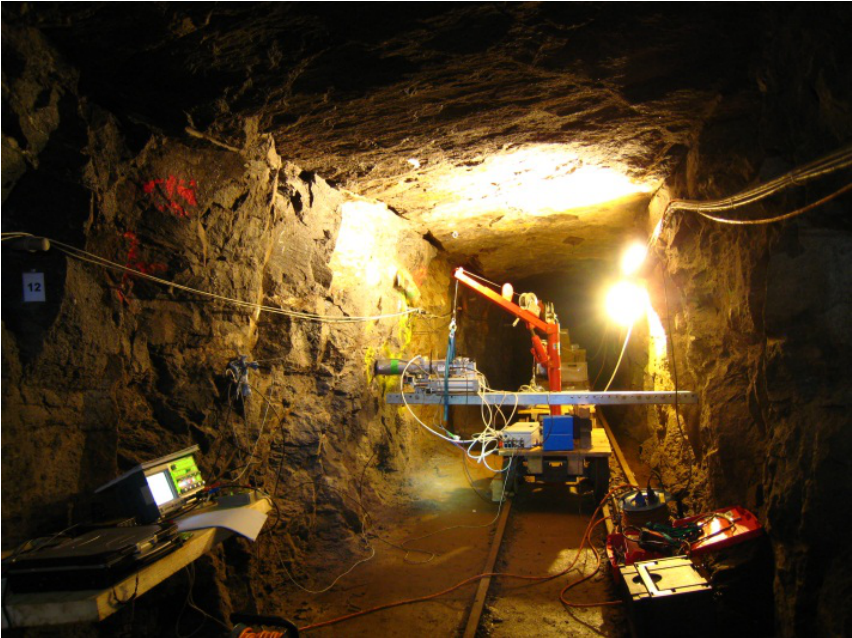
Figure 2: Pneumatic impulse hammer source pre-stressed against the Richtstrecke gallery wall (see Fig.